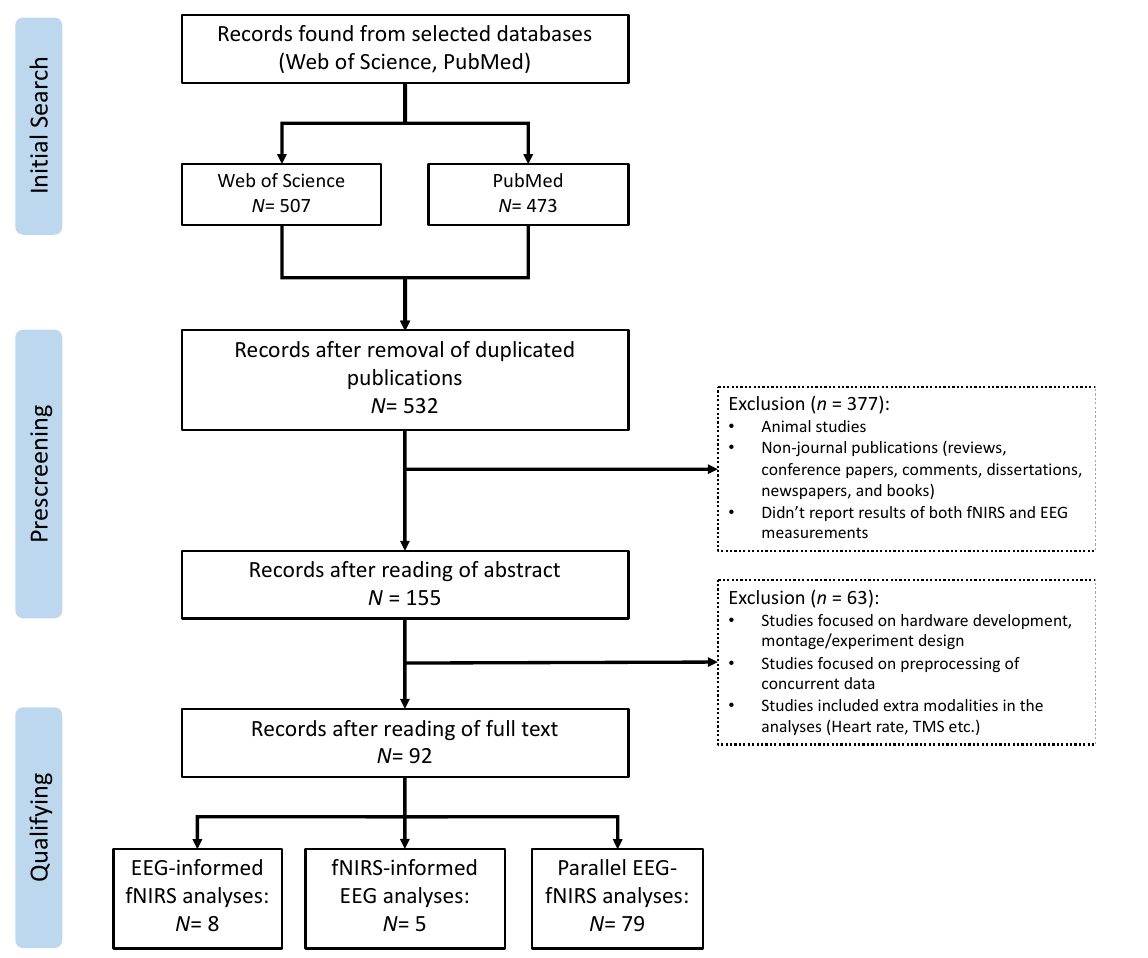
Figure 3. PRISMA flow diagram for the literature review and article selection.